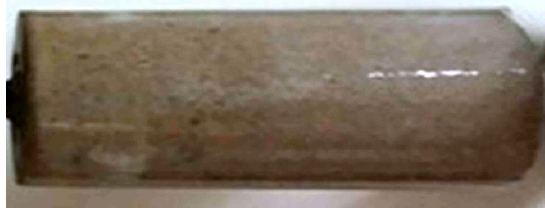
Figure 9. Wash contact time of 8 min.